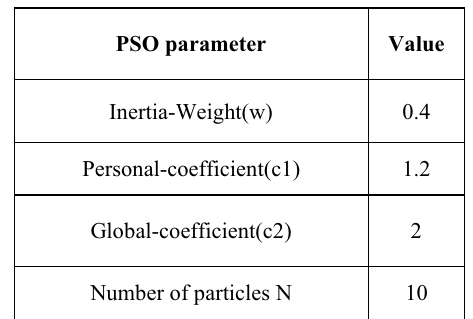
Table 2. The PSO main parameters.